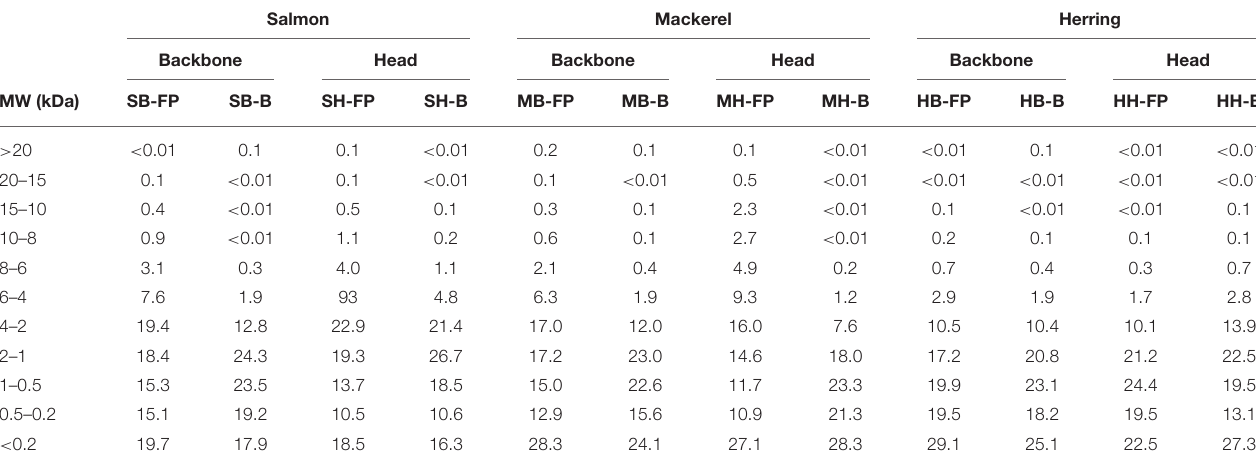
TABLE 5 | Molecular weight distribution (wt %) of hydrolysates based on salmon (S), mackerel, and herring (H) backbones (B) and heads (H) using the enzymes Food Pro PNL (-FP) and Bromelain (-B). Salmon Mackerel Herring Backbone Head Backbone Head Backbone